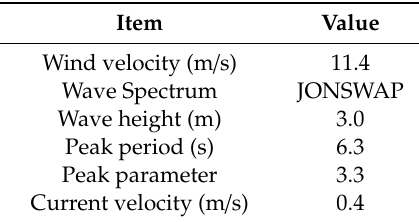
Table 3. Rated operational sea state.